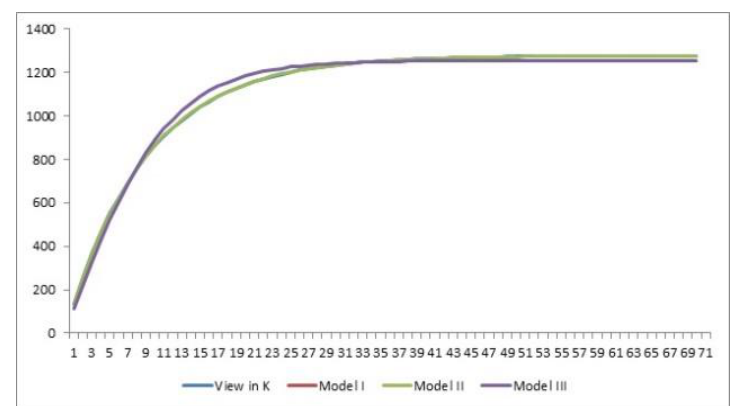
Figure 3. Goodness of fit curve of Dataset